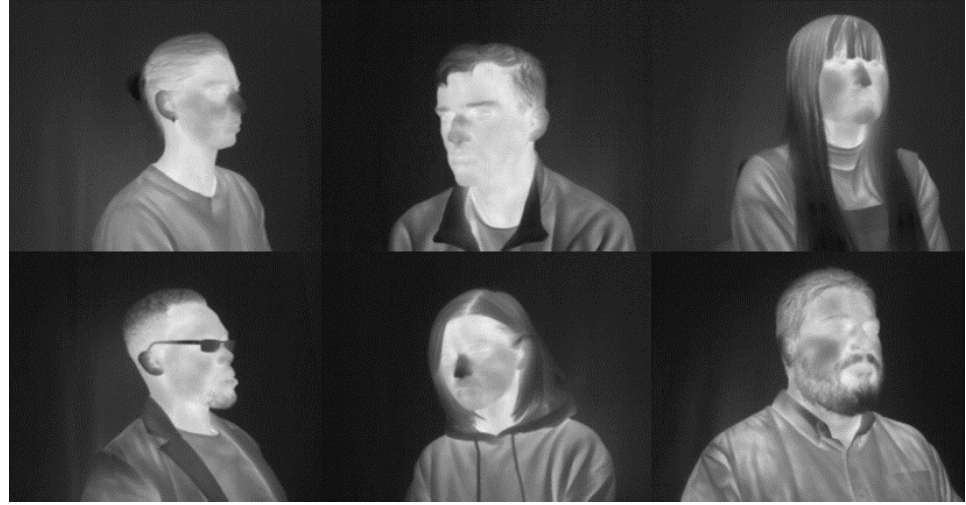
Figure 5. Examples of dataset images [45].